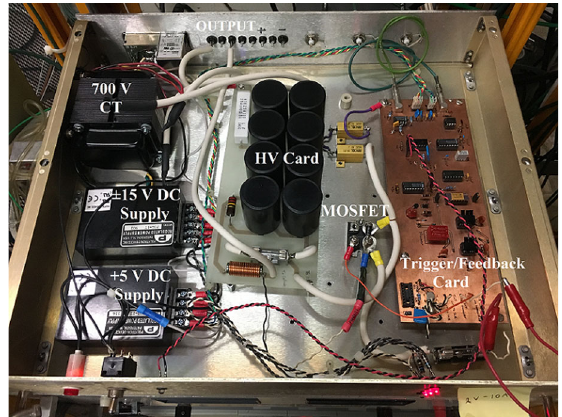
FIG. 13. Performance of the current-regulated modulator over three days running in the ion source. The arc current remains constant whereas the arc voltage and vacuum pressure